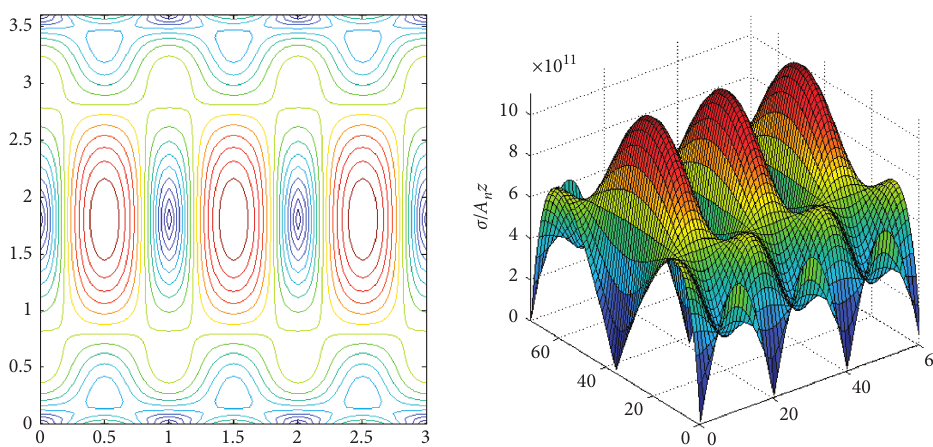
Figure 4: The maximum shear of the 6 th order mode (S-C-S-C).